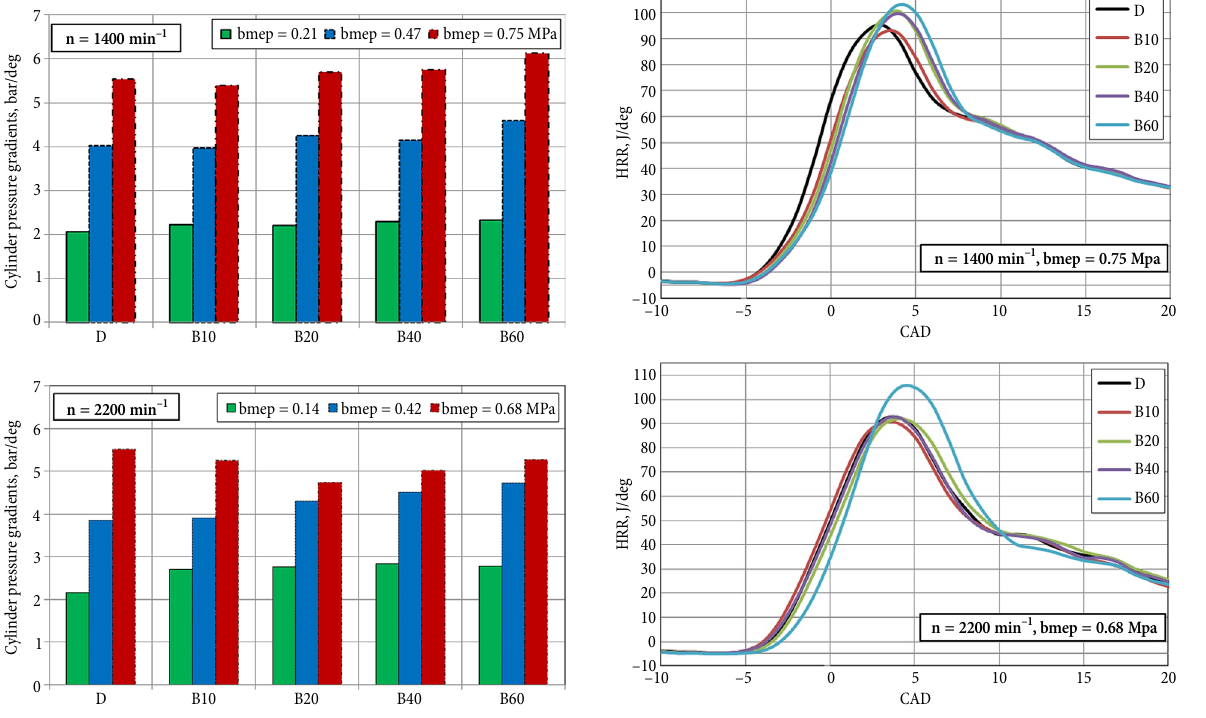
Fig. 6. HRR as function of CAD for the investigated fuels at full engines load and two